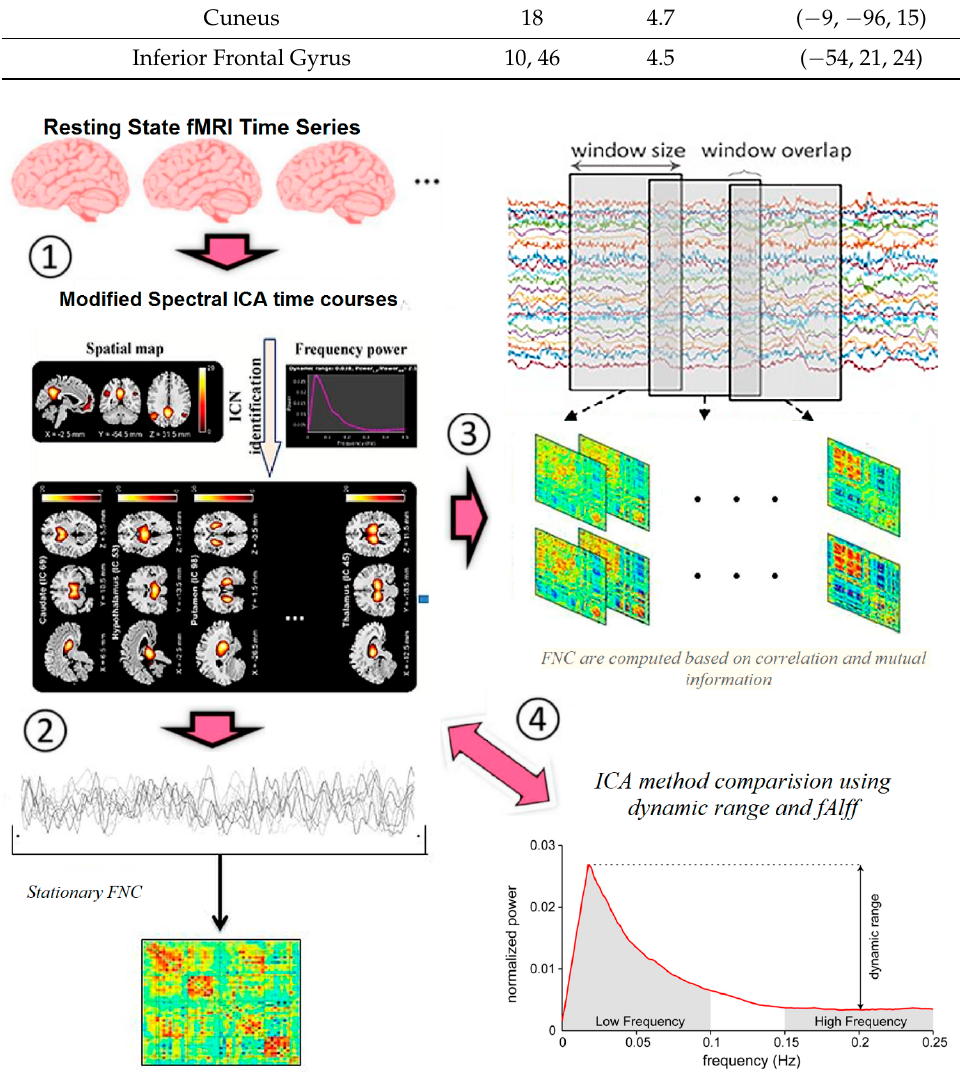
Figure 1. Method block diagram . Table 2. MS and healthy group differences using fMRI .